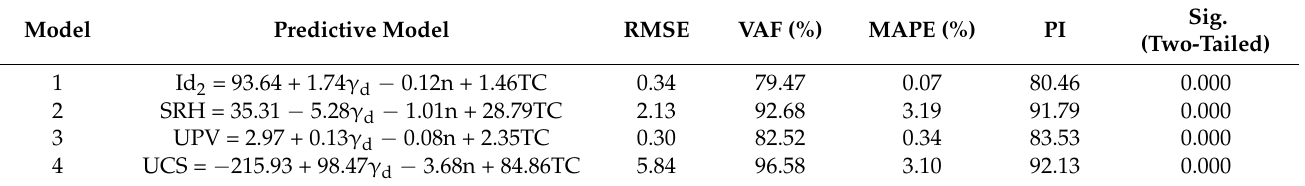
Table 9. Predictive models from multiple regression analysis and statistical parameters for perfor- mance of the models.